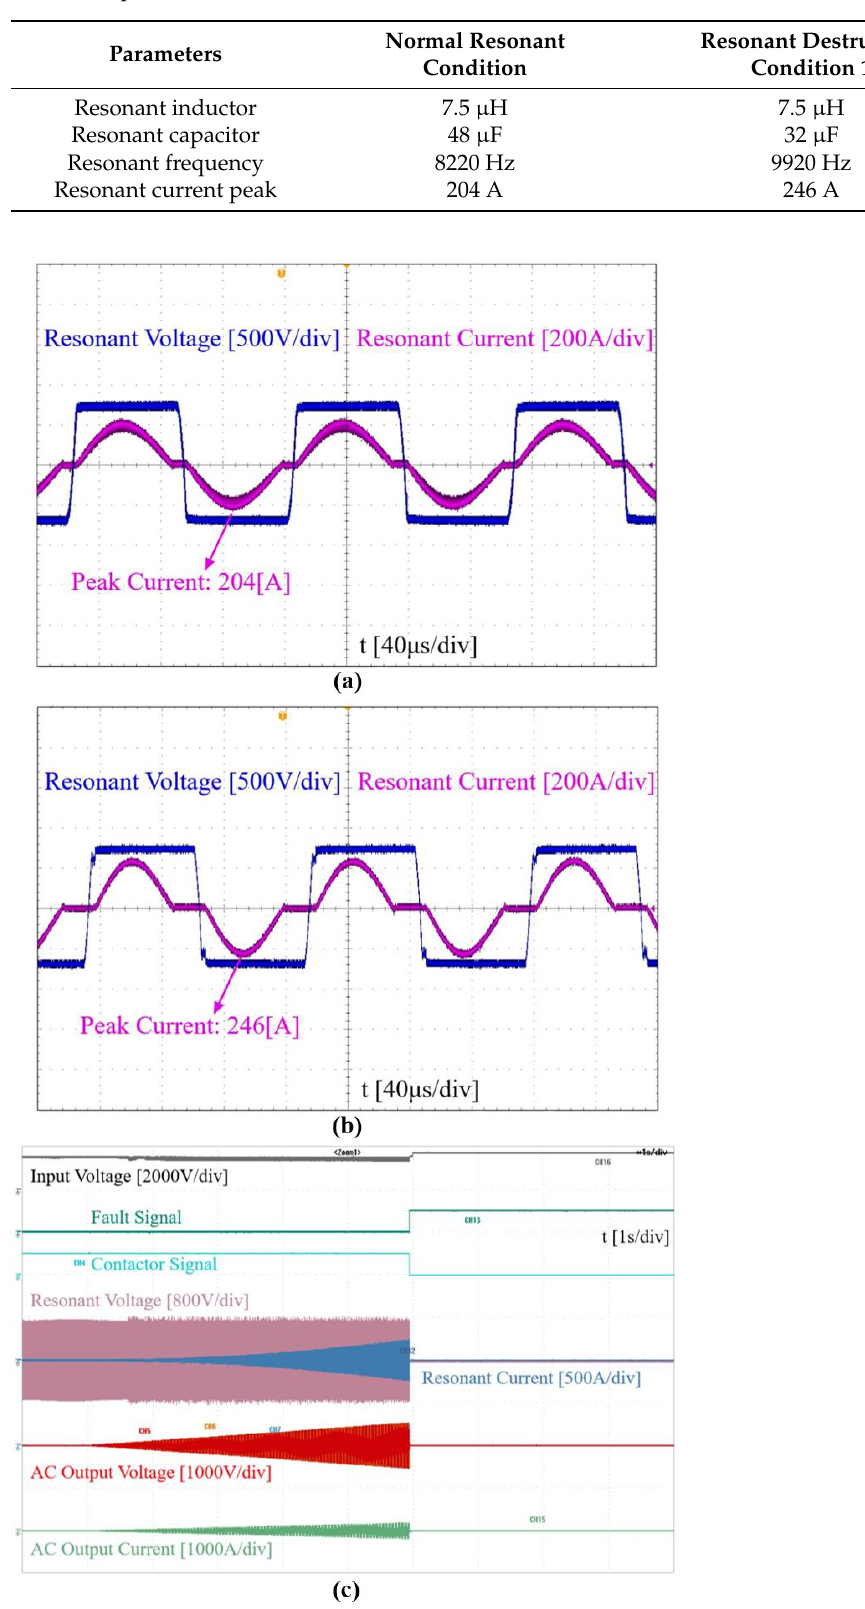
Table 5. Experimental results of resonant destruction detection.